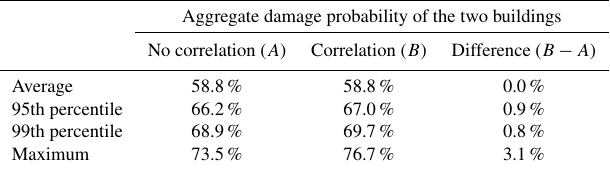
Table 9. Tsunami risk assessment